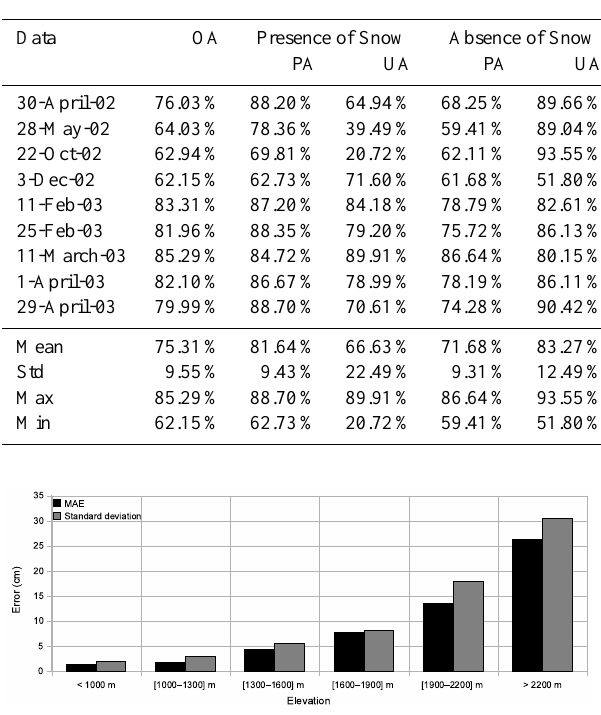
Fig.4. MeanAbsoluteErrorandstandarddeviationinregression taskasafunctionofelevationranges. Fig. 4. Mean absolute error (MAE) and standard deviation in re- gression task as a function of elevation ranges.